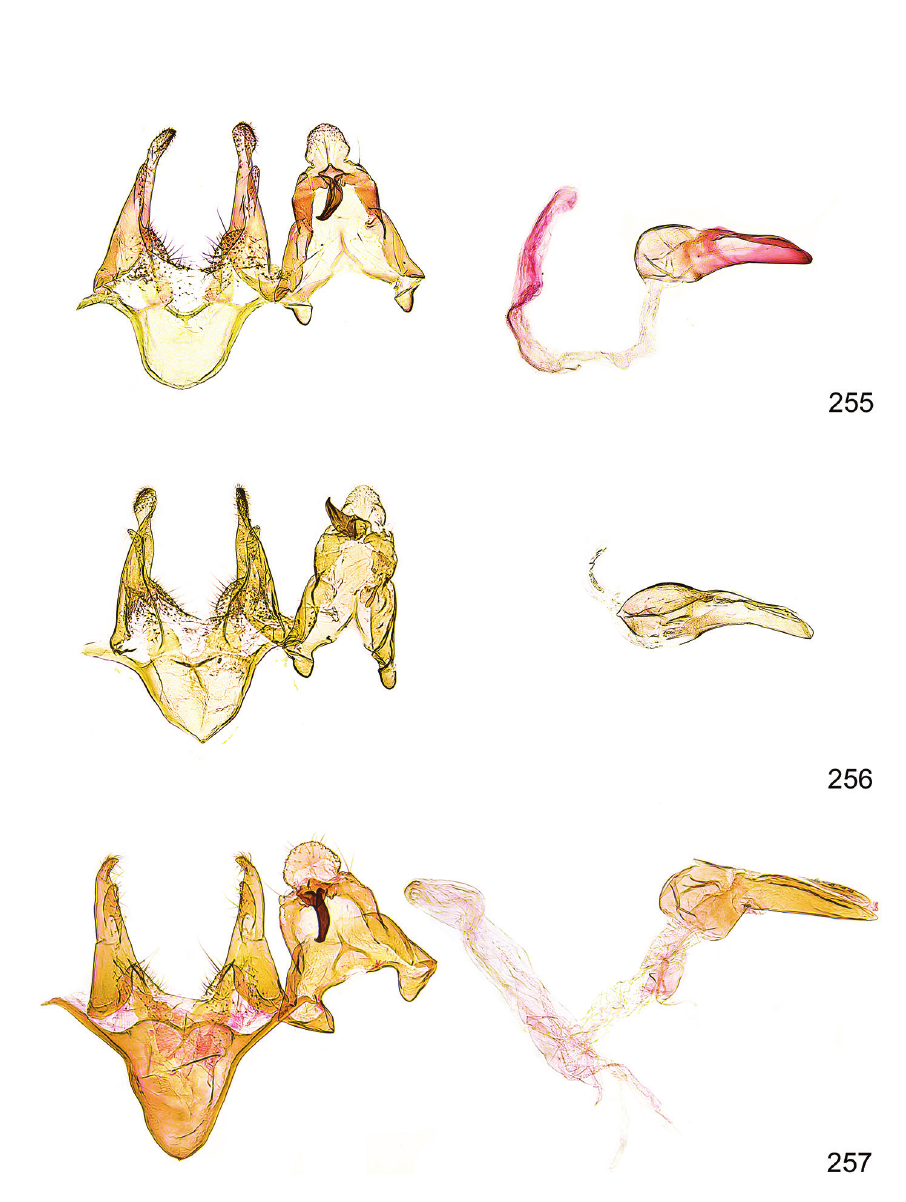
Figures 255–257. Megacraspedus male genitalia. 255 M. quadristictus Lhomme, 1946 – France, GEL 1204 P.H. (TLMF) 256 M. quadristictus Lhomme, 1946 – France, GEL 1207 P.H. (TLMF) 257 M. eburnellus Huemer & Karsholt, 2001 – Paratype, Italy, GEL 1007 P.H.